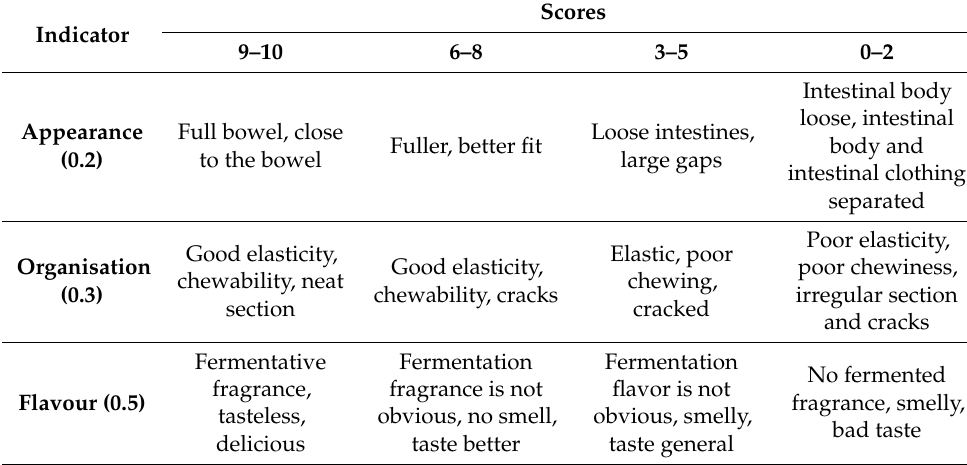
Table 1. Sensory evaluation of fermented